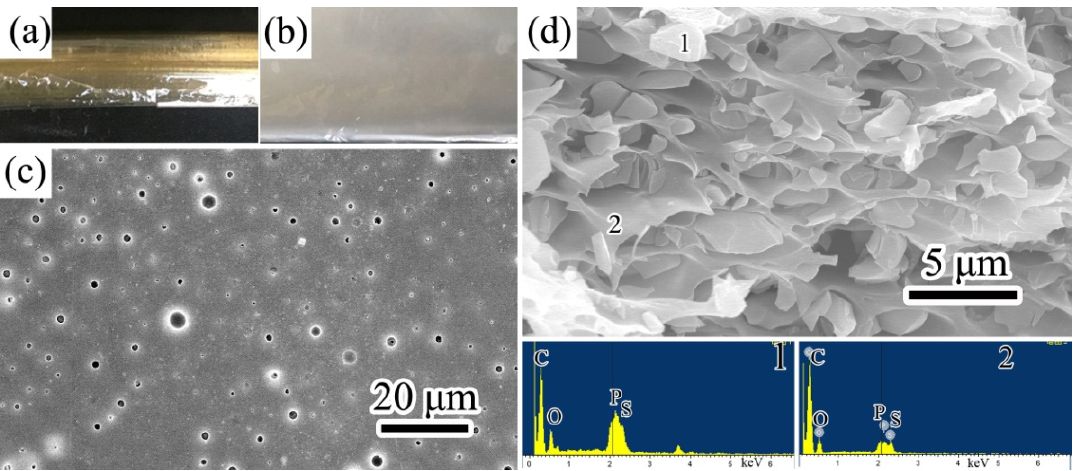
Figure 2. Optical images of the ( a ) PEK-C film and ( b ) PS100 film, and SEM images of ( c ) the surface of PS100 film, and ( d ) the fracture surface of PS100 film.